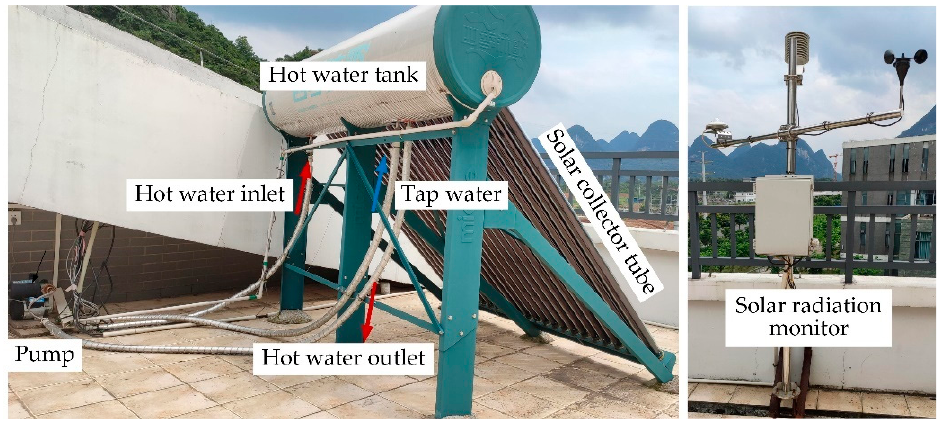
Figure 6. Solar water heating system.